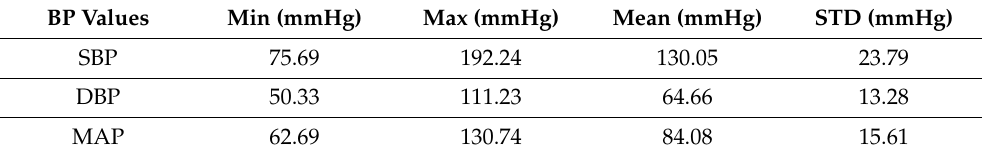
Table 1. Summary of data used for testing network